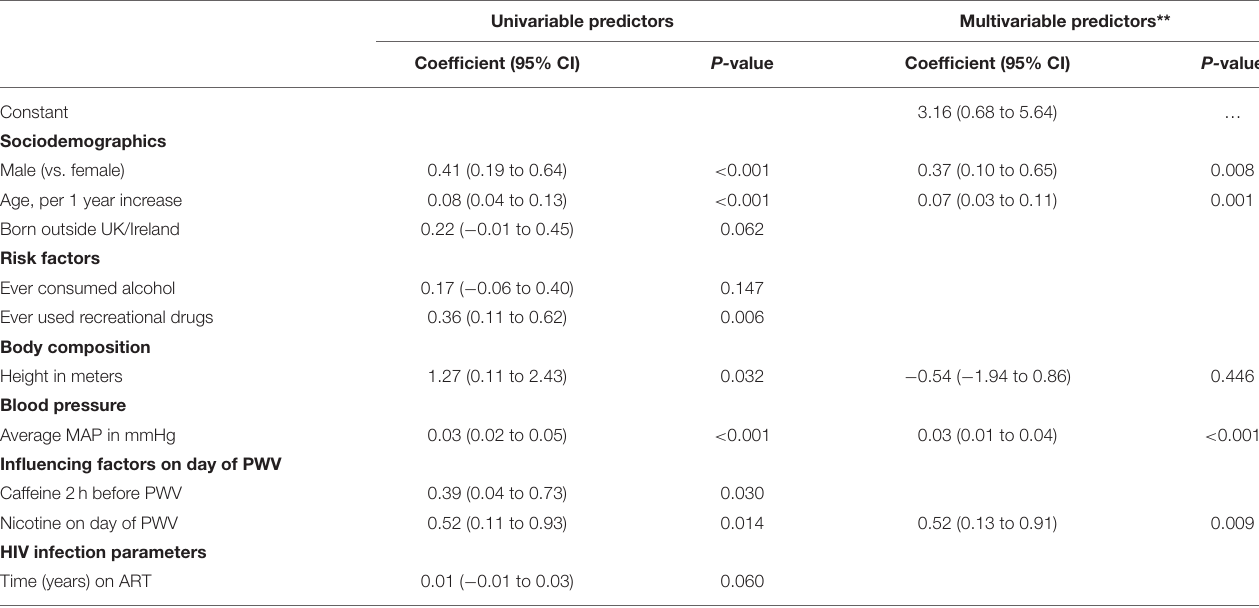
TABLE 4 | Univariable and multivariable predictors of PWV in PHIV